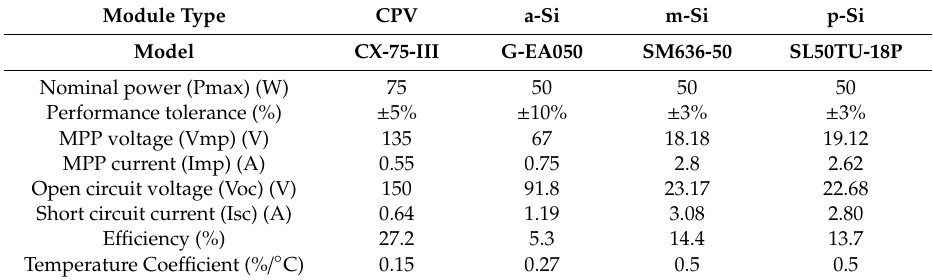
Table 2. Technical information of the PV modules. (standard test conditions: air mass 1.5;